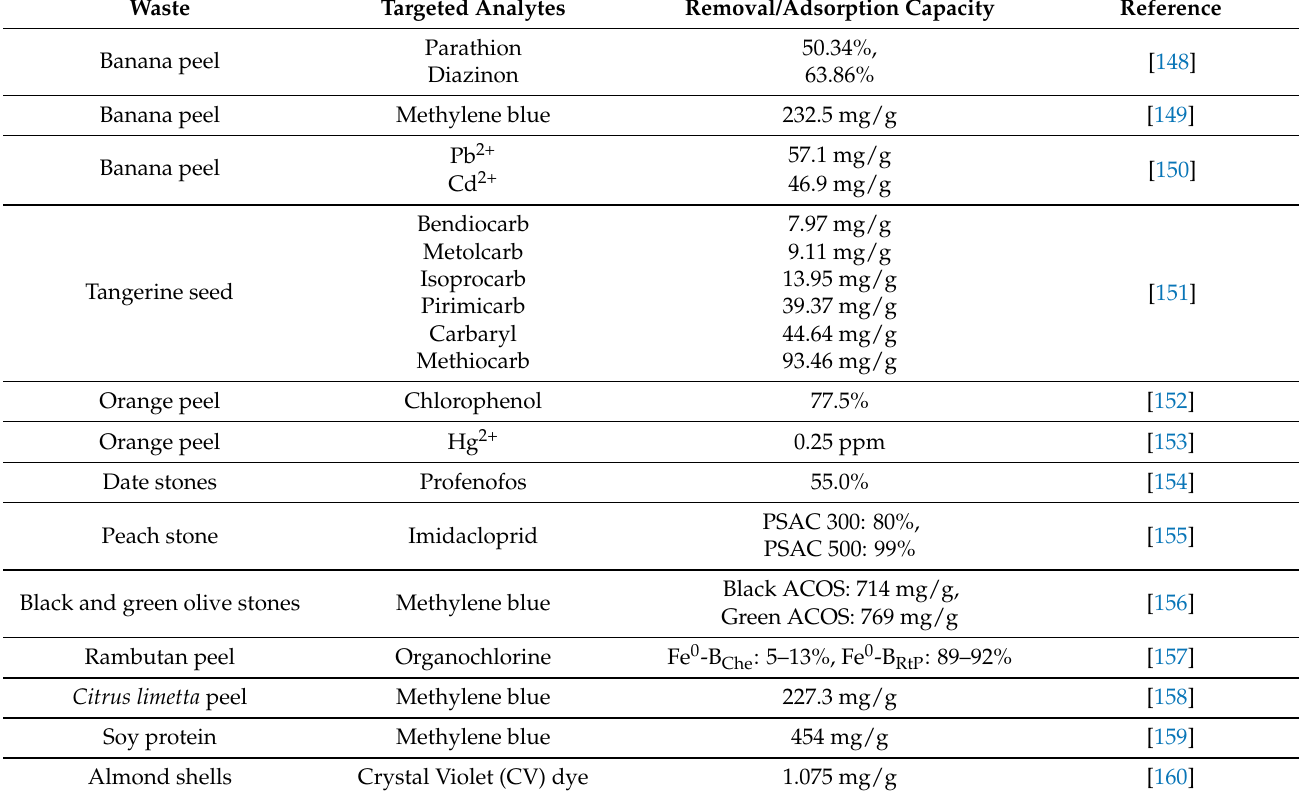
Table 5. Removal or adsorbent capacities of targeted analytes using fruits and vegetables